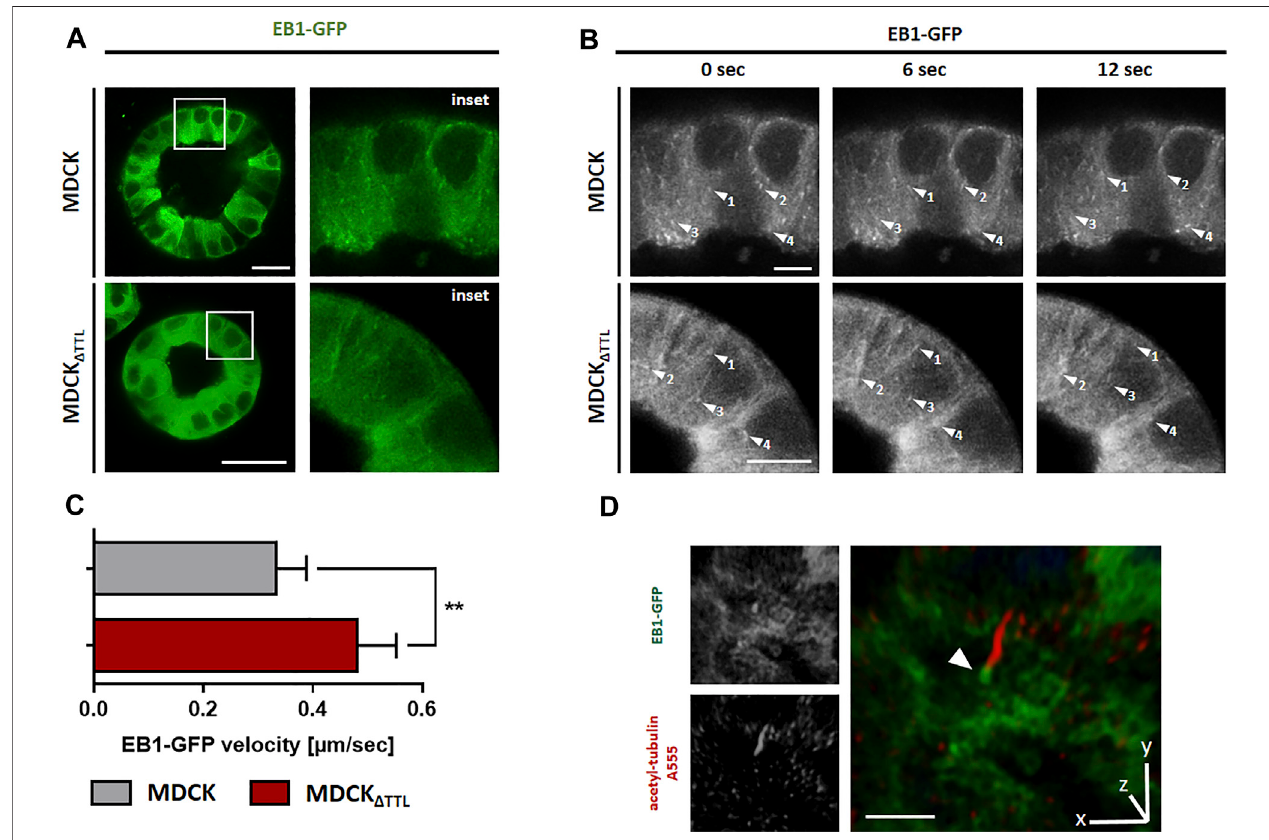
FIGURE 6 | TTL-knockdown promotes EB1 dynamics in MDCK cysts. (A) Living MDCK and MDCK Δ TTL cells stably transfected with EB1-GFP were cultured in Matrigel for 7 days. Dynamic of EB1-GFP (green) was analyzed by fl uorescence microscopy at 37 ° C and a humidi fi ed atmosphere of 5% CO 2 . Scale bars: 20 µm. (B) Time-lapse imaging was recorded for 12 s. Each arrowhead indicates EB1-GFP comet-like accumulation, traced for several time points. Scale bars 4 µm. (C) Quanti fi cation of EB1-GFP velocities in MDCK and MDCK Δ TTL cysts. Experiments were quanti fi ed with the Imaris Cell Imaging Software. Mean ± s.d., n = 3. Statistical signi fi cance was tested with Student`s unpaired t -test (** p < 0.01). (D) 3D-rendered image of acetylated tubulin staining (primary cilium, red) in EB1-GFP (green) expressing MDCK Δ TTL cyst. Arrowhead indicates accumulation of EB1 around the ciliary base. Scale bar: 5 µm.